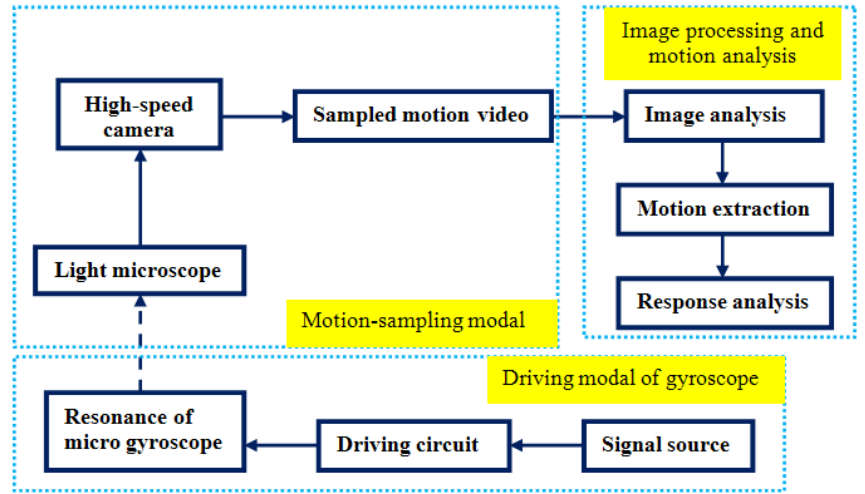
Fig.1 function block diagram of computer vision measuring system